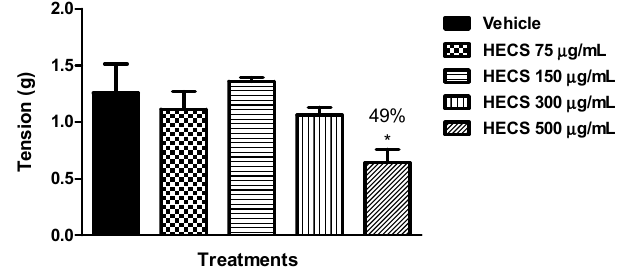
Figure 7. Effect of the hydroalcoholic extract of C. sicyoides— HECS (75, 150, 300 and 500 μ g/mL) on the phasic contractions induced by 60 mM KCl in isolated mouse ileum in vitro ( n = 5). The results are expressed as the mean ± S.E.M., and statistical significance was determined by ANOVA followed by Dunnett’s test; * p < 0.05 compared to the control (vehicle). The numbers in percentage in the figure corresponds to the reduction of tension in relation to the control group treated with vehicle.